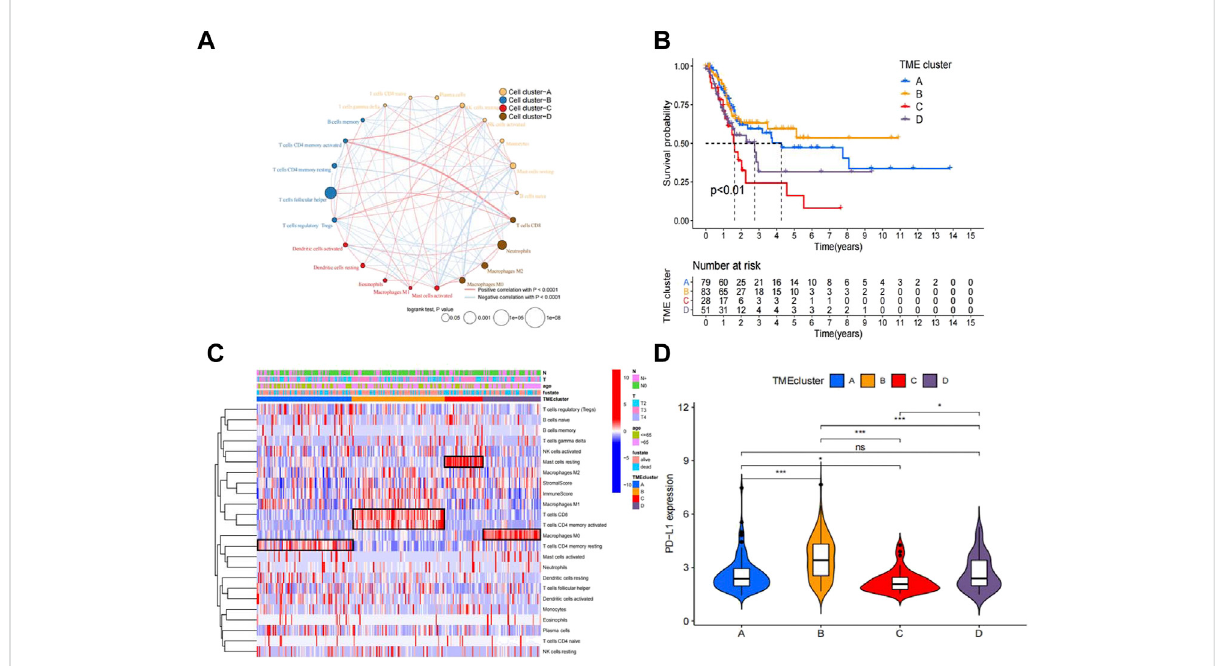
FIGURE 2 Landscape of the TME in bladder cancer and characteristics of TME subtypes. (A) The interaction between TME cell type in bladder cancer. Cell cluster A, orange; cell cluster B, blue; cell cluster C, red; cell cluster D, brown.The size of each cell represents survival impact of each TME cell type, calculation usedtheformulalog10(log-ranktest p valuesindicated)respectively. ThelineslinkingTMEcellsshowedtheirinteractions,andthickness represented the correlation estimated by Spearman correlation analysis and strength between regulators. Negative correlation was indicated with blue and positive correlation with red. (B) . Kaplan – Meier curves for overall survival (OS) of 241 bladder cancer patients from training cohorts (TCGA+GSE48075)withtheTMEin fifi ltrationclusters.ThenumbersofpatientsinTMEcluster-A,-B,-C,and-Dphenotypesare n =79, n =83, n =28, n = 51 respectively. Log-rank test shows overall p < 0.01. (C) . Heatmap of 22 TME cells and ImmuneScore for 249 patients in the training cohort. (D) . Comparison of the PD-L1 among four TME subtypes in the training cohort.* p < 0.05, ** p < 0.01, *** p <